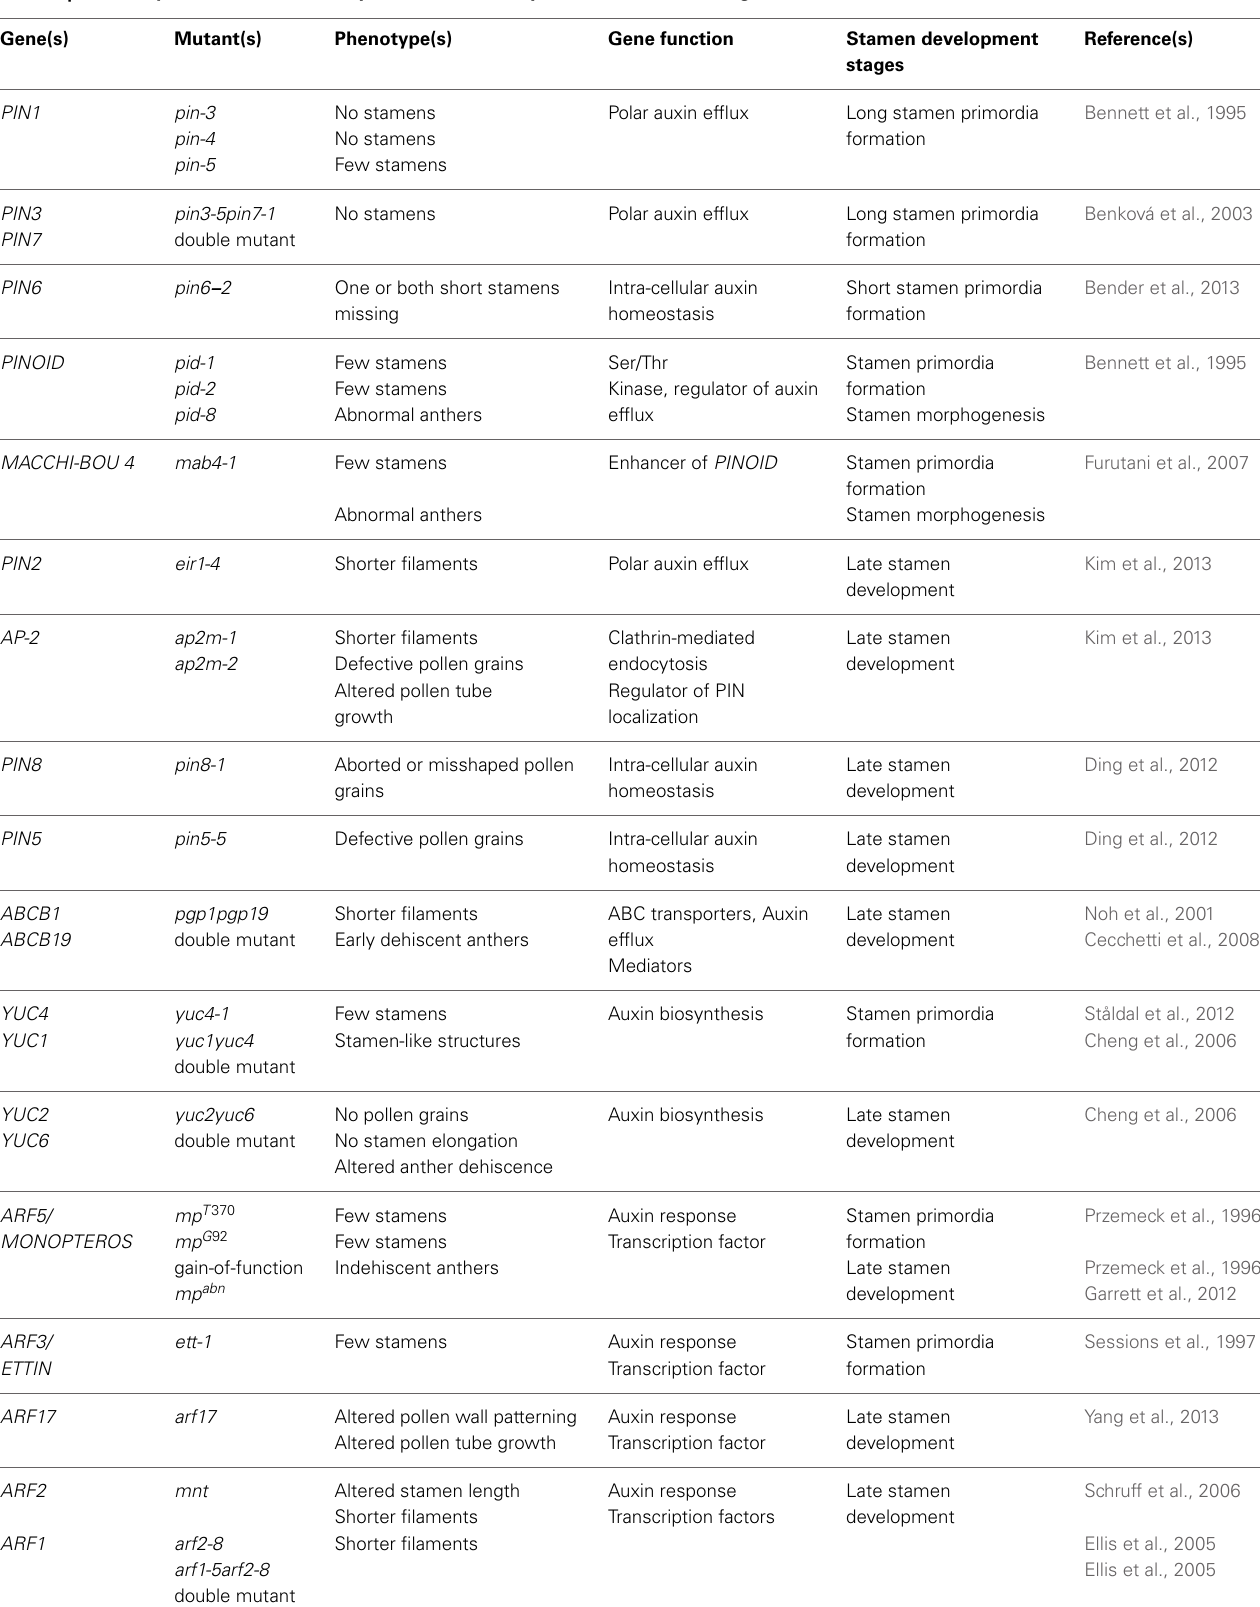
Table 1 | Summary of the role in Arabidopsis stamen development of auxin-related genes.